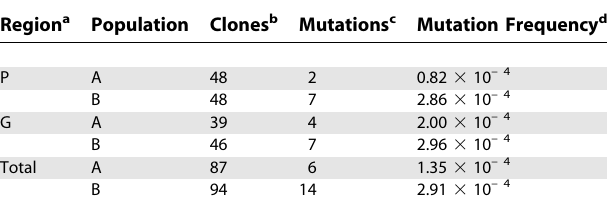
a The P region spanned nucleotides 1,771 to 2,279 of the viral genome and included approximately half of the P gene, the P-M intergenic region, and the first 30 bases of the M gene. The G region spanned nucleotides 3,836 to 4,349, all belonging to the G gene. b Number of cDNAs cloned into E. coli . c Number of different mutations observed. Mutations that were observed in more than one clone were counted only once and insertions/deletions of several consecutive bases were counted as single mutations. d Mutations divided per the total number of sequenced